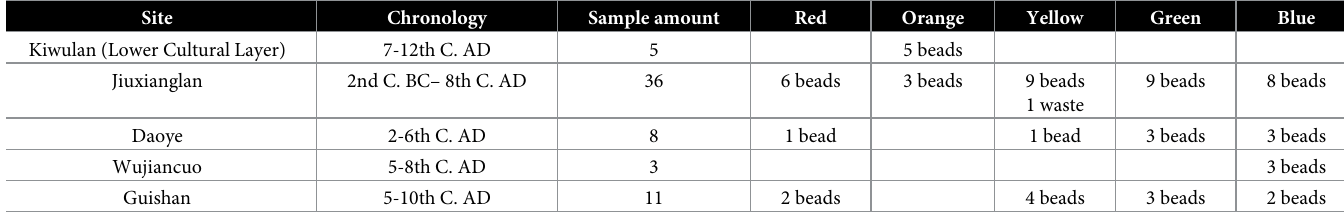
Table 1. Summary of the study sites and the context of excavated glass beads.